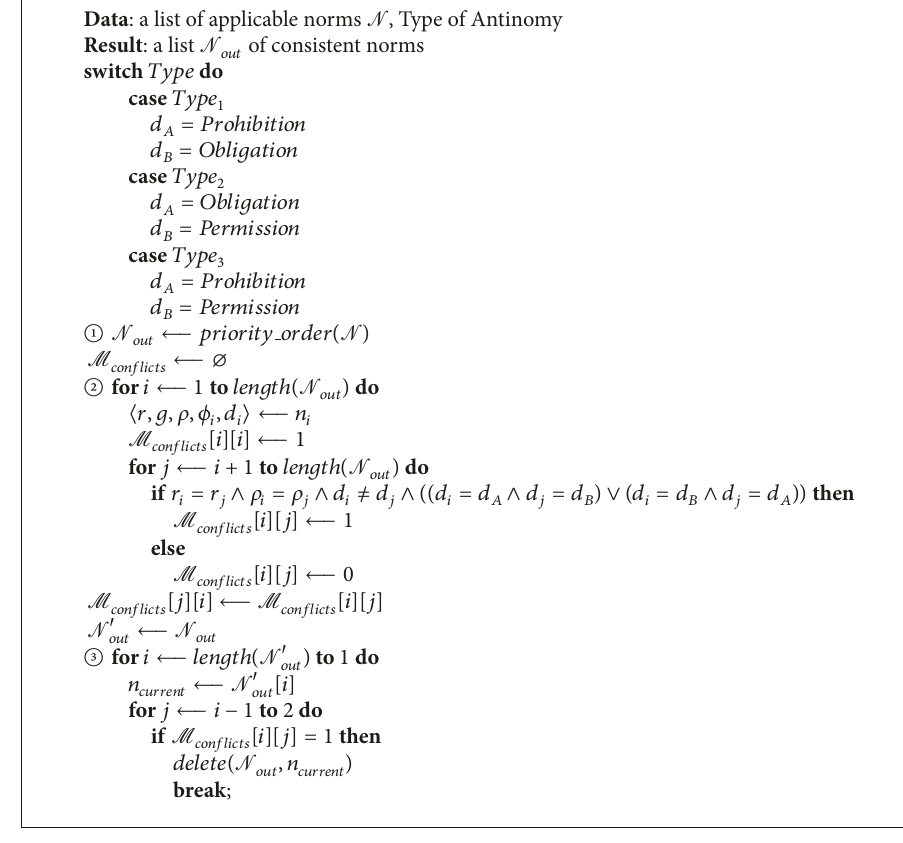
Algorithm 4: Check Antinomy.